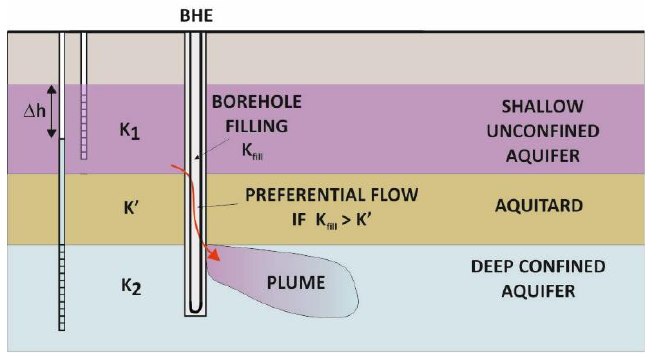
Figure 2. Conceptual model of the cross-contamination between two aquifers induced by a permeable borehole. Modified from Casasso and Sethi borehole. Modified from Casasso and Sethi [10].